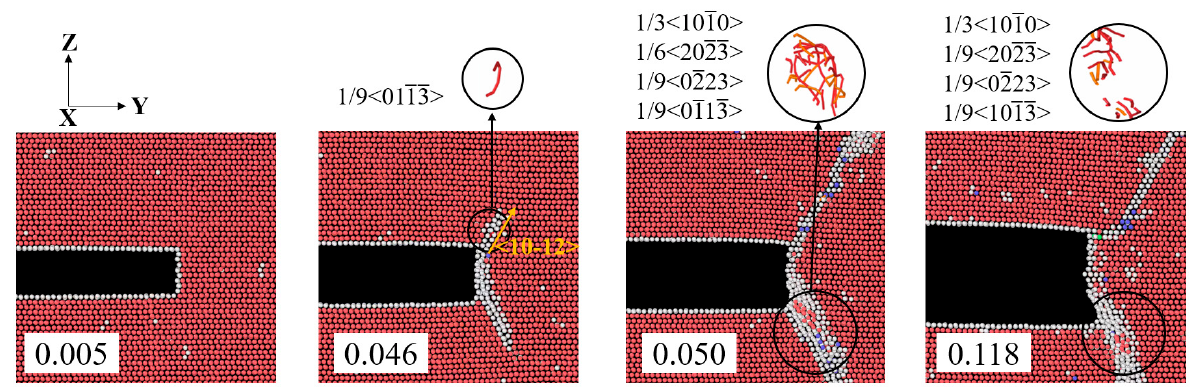
Figure 6. Void growth accompanied by dislocation emission in the void system.